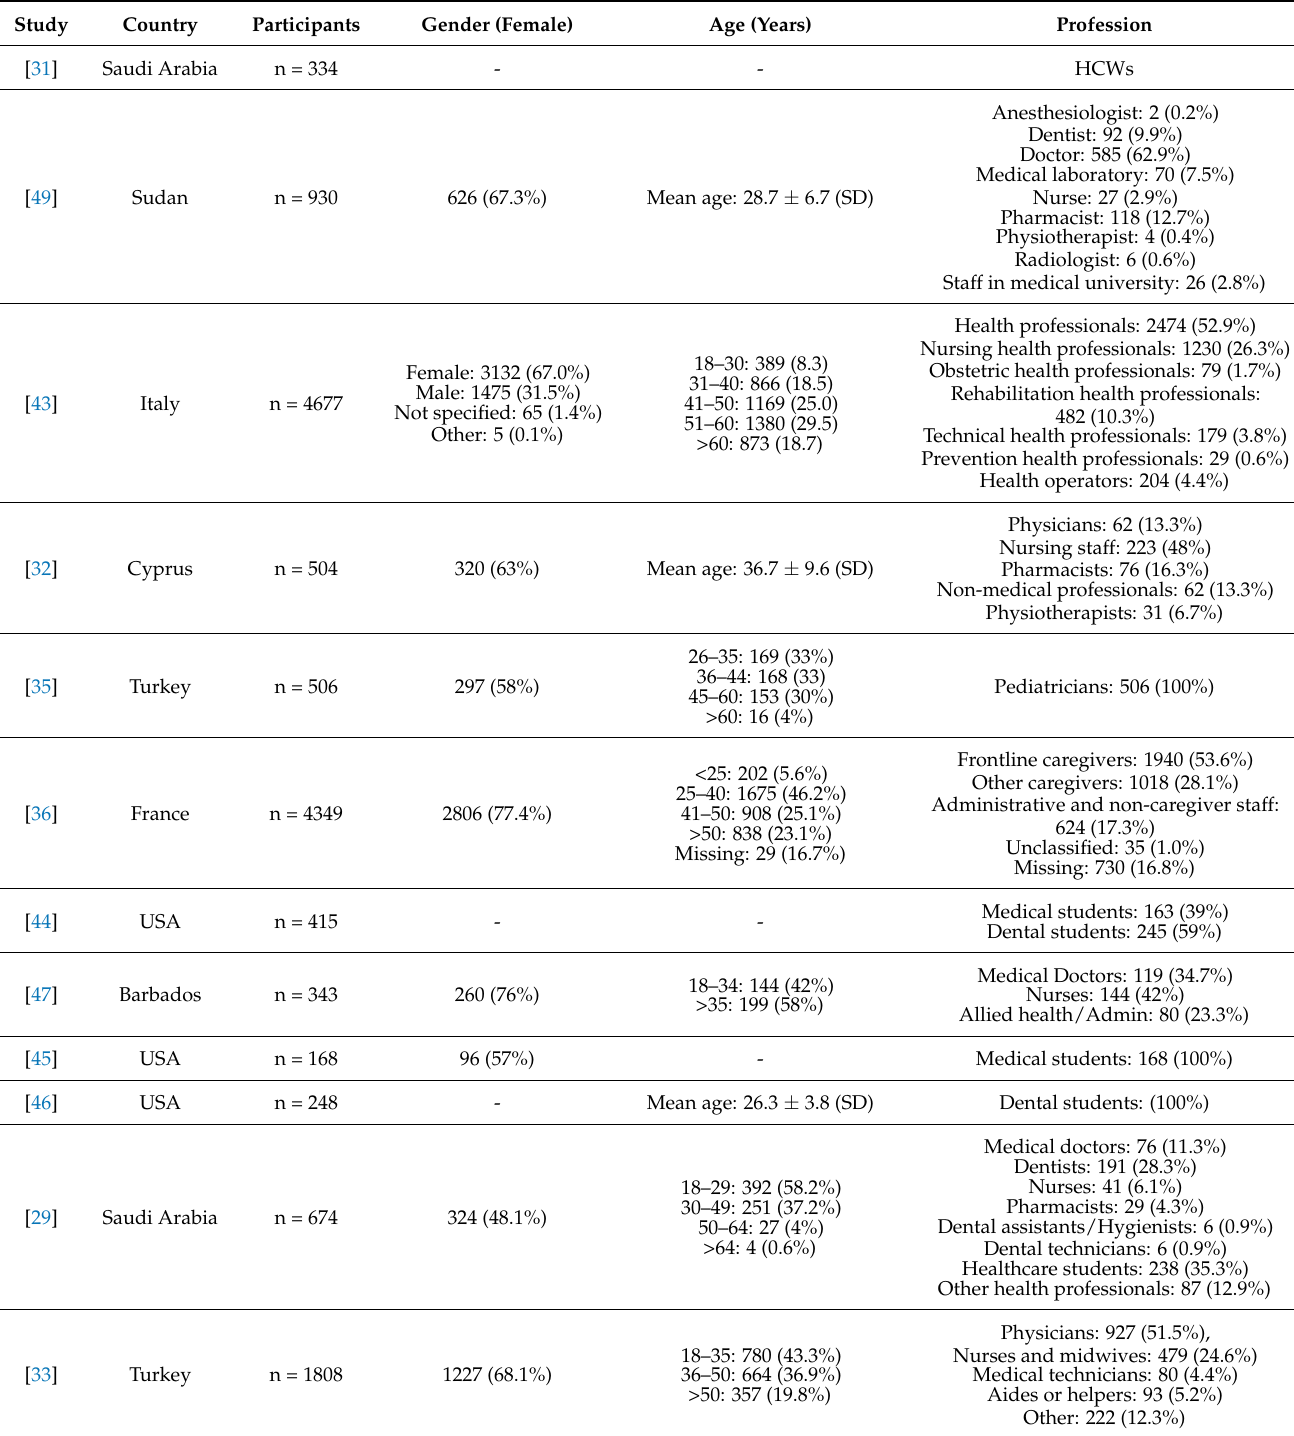
Table 1. Demographic features of the participants included in the meta-analysis: HCWs’ acceptance of COVID-19 vaccination mandates for the general